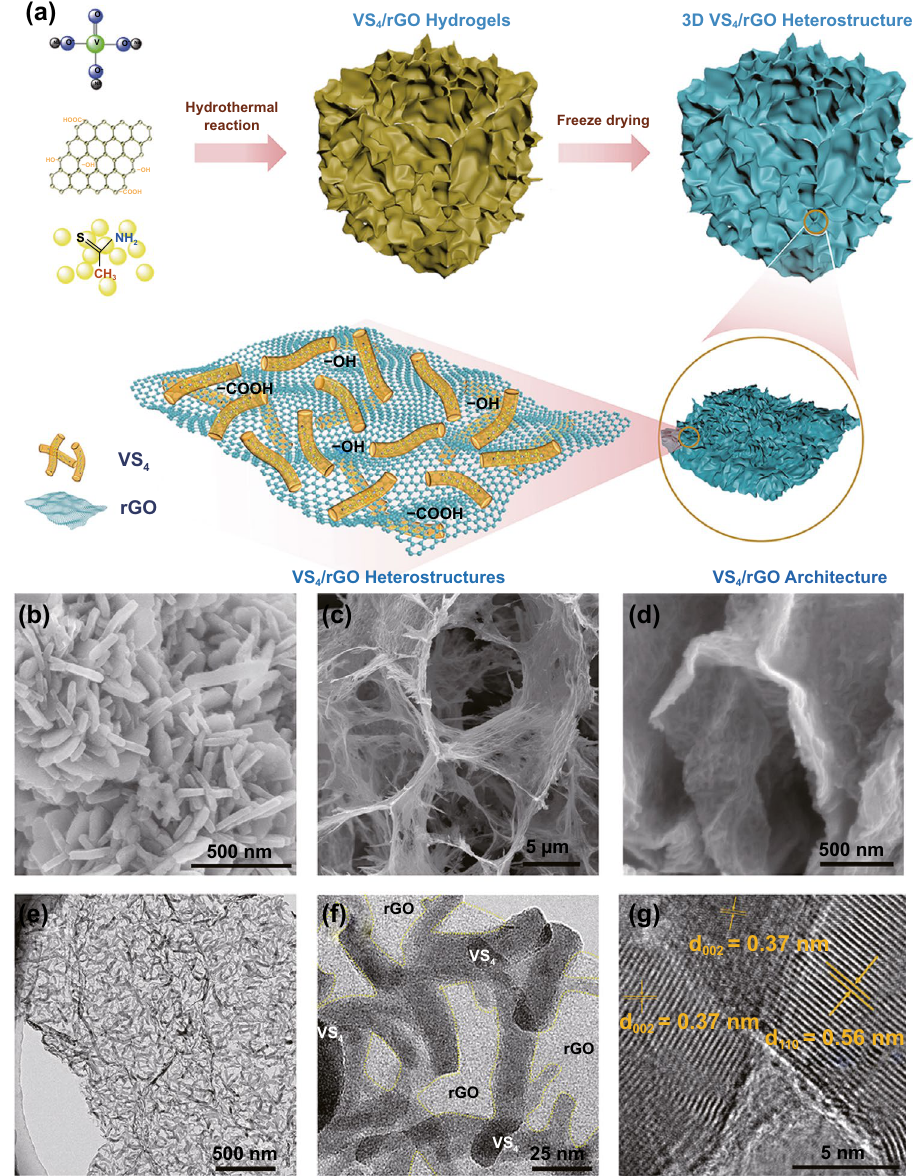
Fig. 1 a Schematic illustration of the synthesis processes for self-assembly VS 4 /rGO heterostructure. SEM image of b VS 4 nanorods, c rGO architecture, and d VS 4 /rGO heterostructure. e, f TEM images of VS 4 /rGO heterostructure with different magnification. g HRTEM images of VS 4 nanorods showing the d-spacing of 0.56 nm in the (110) plane and rGO showing the d-spacing of 0.37 nm in (0 0 2)